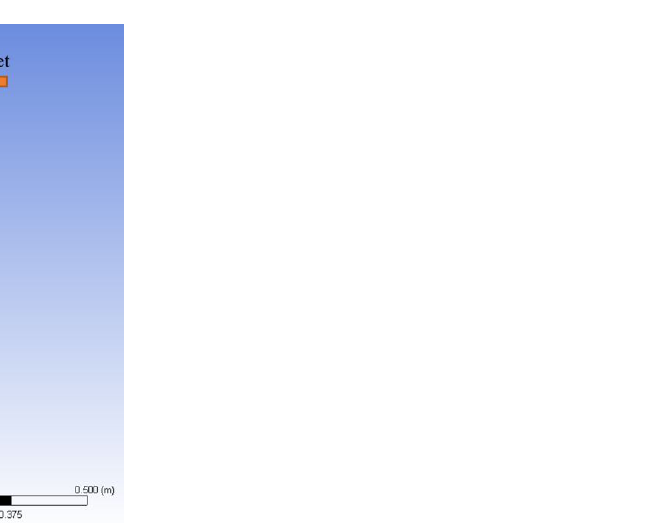
Figure 2. Three-dimensional representation of the simulated domain: the hot air is introduced from the inlet fluid boundary (orange arrow), and ejected with the water as a mixture from the outlet (green arrow). The glass wall boundary and the fluid domain are reported in grey and in light grey,